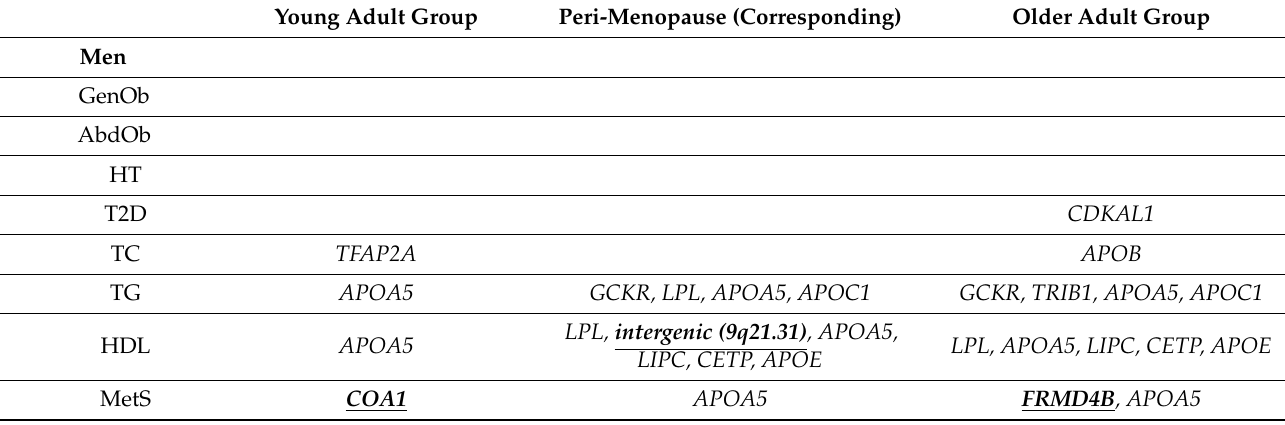
Table 3. The significant genetic risk factors according to the age and sex